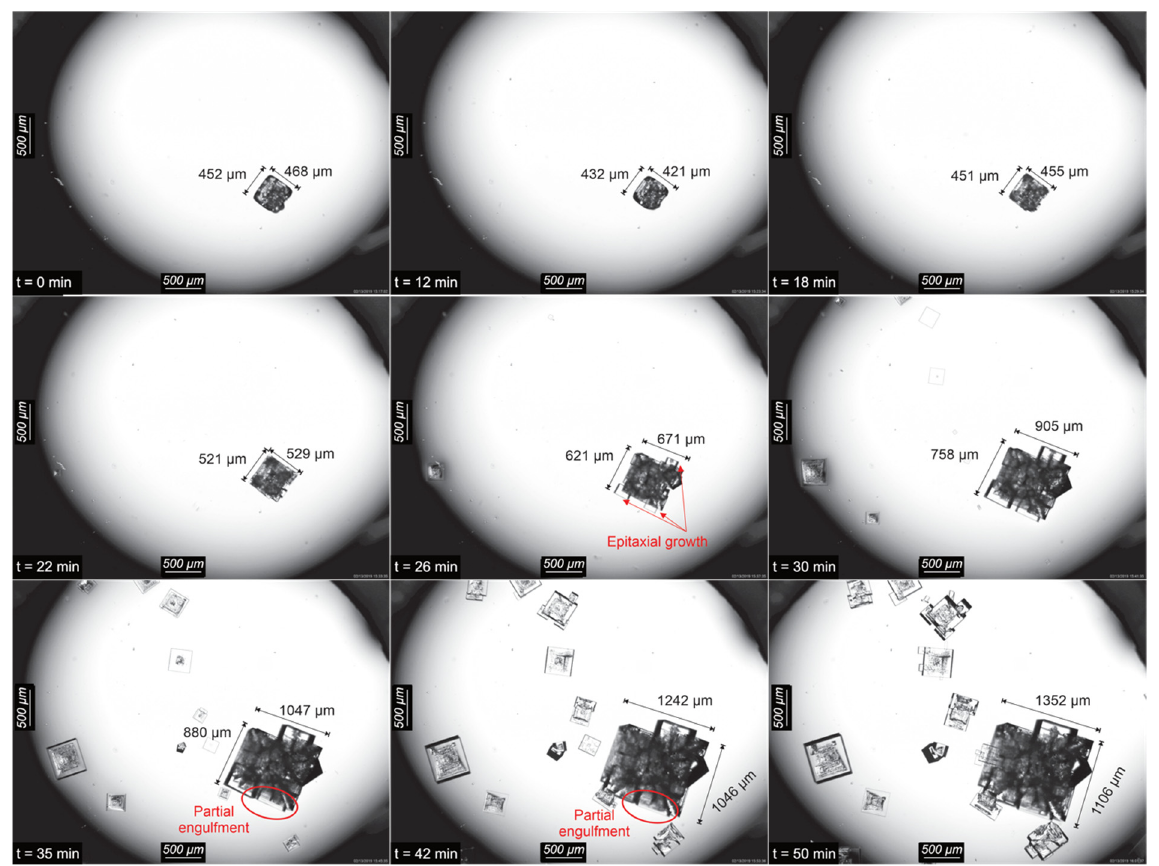
Figure 5. Optical photomicrographs of a NaCl–KCl–H 2 O droplet seeded with KCl under evaporation.